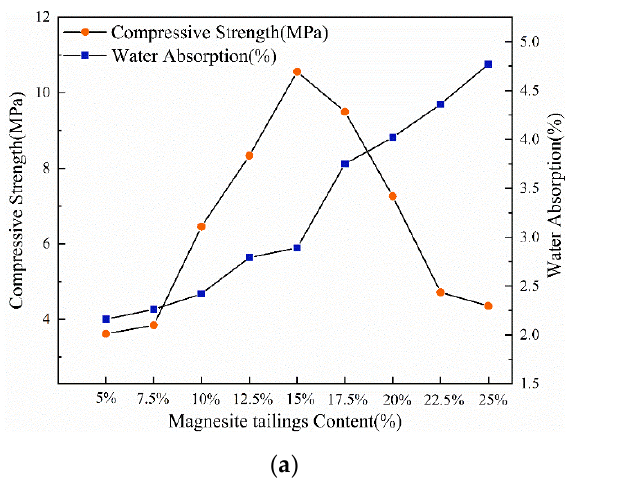
Figure 3. Properties of the ceramsite at different magnesite tailings content ( a ) compressive strength and water absorption, ( b ) apparent density and bulk density . and water absorption, ( b ) apparent density and bulk